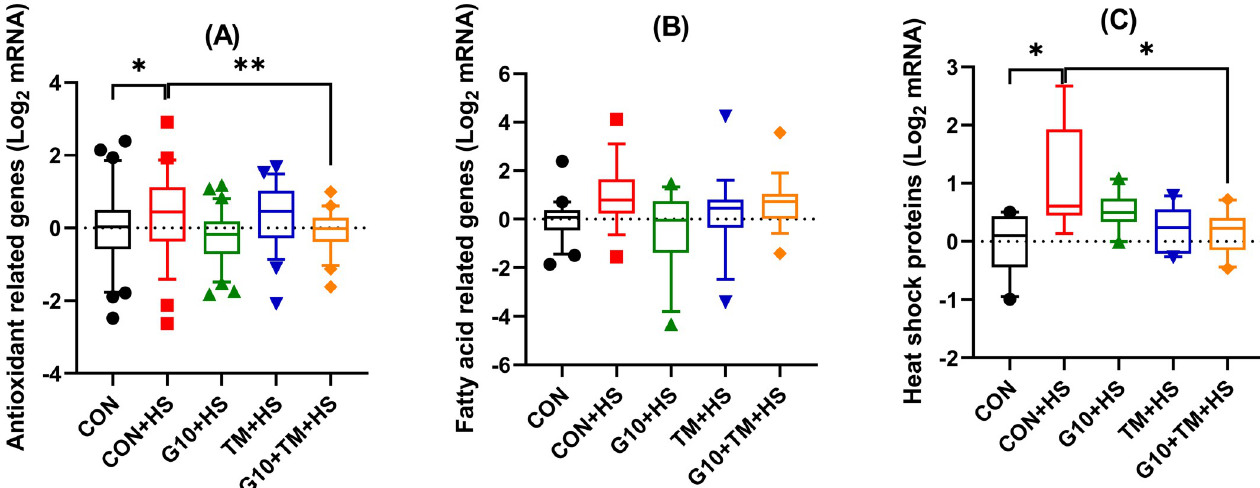
Fig 5. Boxplots showing the assessment of the effects of in ovo feeding of GABA and embryonic thermal manipulation on relative mRNA expression of the set of antioxidant-related genes (A), fatty acid-related genes (B), and heat shock proteins (C) using MANOVA. The treatments are described as follows: CON, chicks hatched from control eggs without in ovo injection and incubated at standard temperature; CON+HS, chicks hatched from control eggs without in ovo injection, incubated at standard temperature but exposed to HS; G10+HS, chicks hatched from eggs injected at 17.5 days of incubation with 0.6mL of 10% GABA dissolved in distilled water and exposed to HS; TM+HS, chicks hatched from thermally manipulated eggs exposed to 39.6˚C for 6 h daily from ED 10 to 18 and exposed to HS; G10+TM+HS, chicks hatched from eggs that received both previous treatments during incubation and exposed to